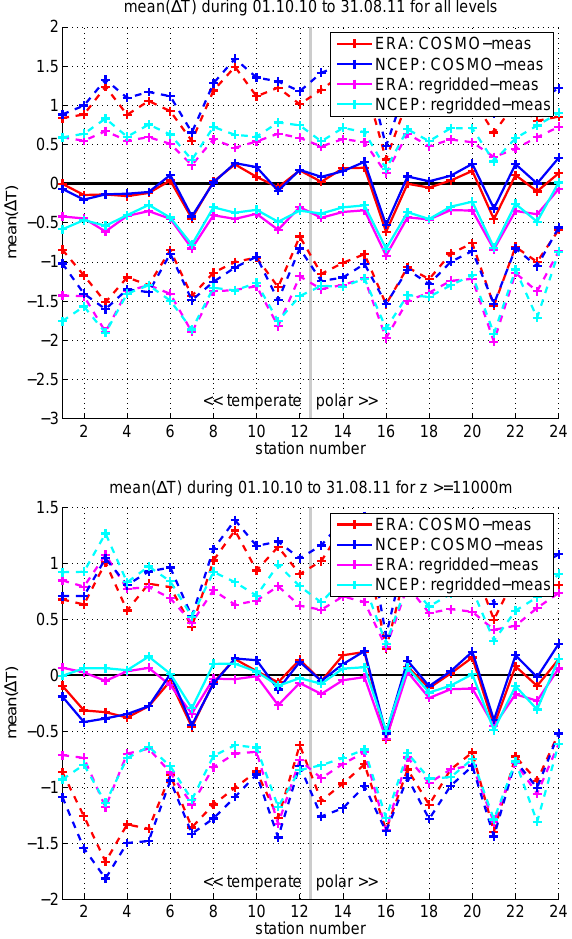
Figure 7. Scatterplot of modeled against measured temperature for polar stations when forcing the model with ERA-Interim (top) and NCEP reanalysis data (bottom). The data were color coded by height to visually inspect the variability in each height section. The statistics in the upper left hand corner refer to the whole data set.